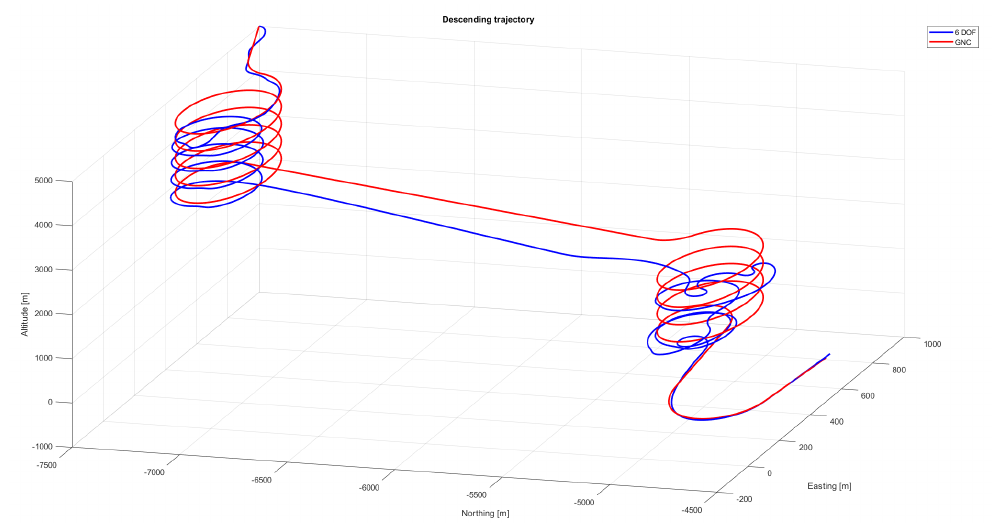
Figure 21. Simulated trajectory followed by a parafoil–payload system (system parameters as for Section 2.1) on a windy day (the used wind profile is shown in Figure 23).